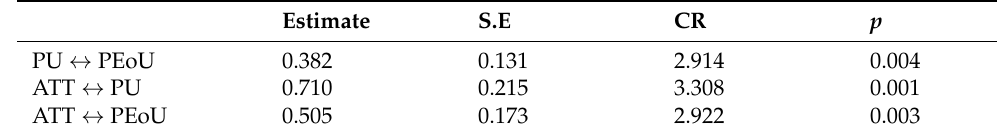
Table 5. Covariances between